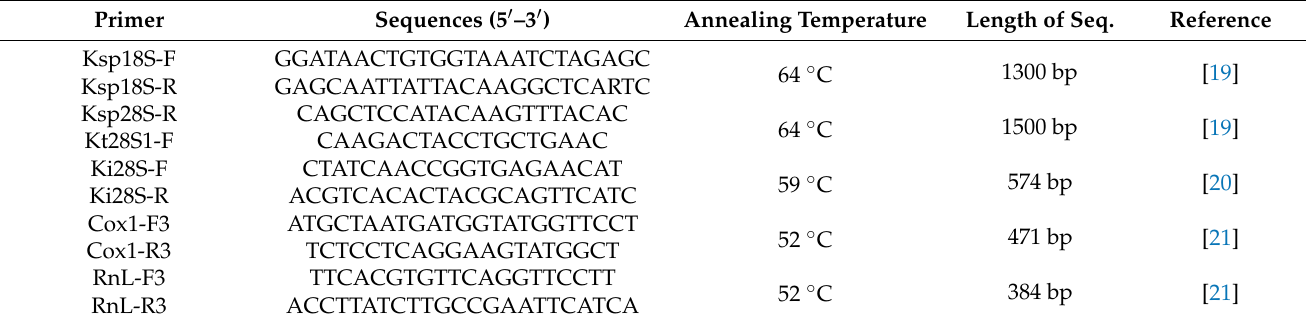
Table 1. Primers used to amplify and sequence the nucleotides of the rDNA, cox-1 , and rnl genes. Primer Sequences (5 (cid:48) –3 (cid:48) ) Annealing Temperature Length of